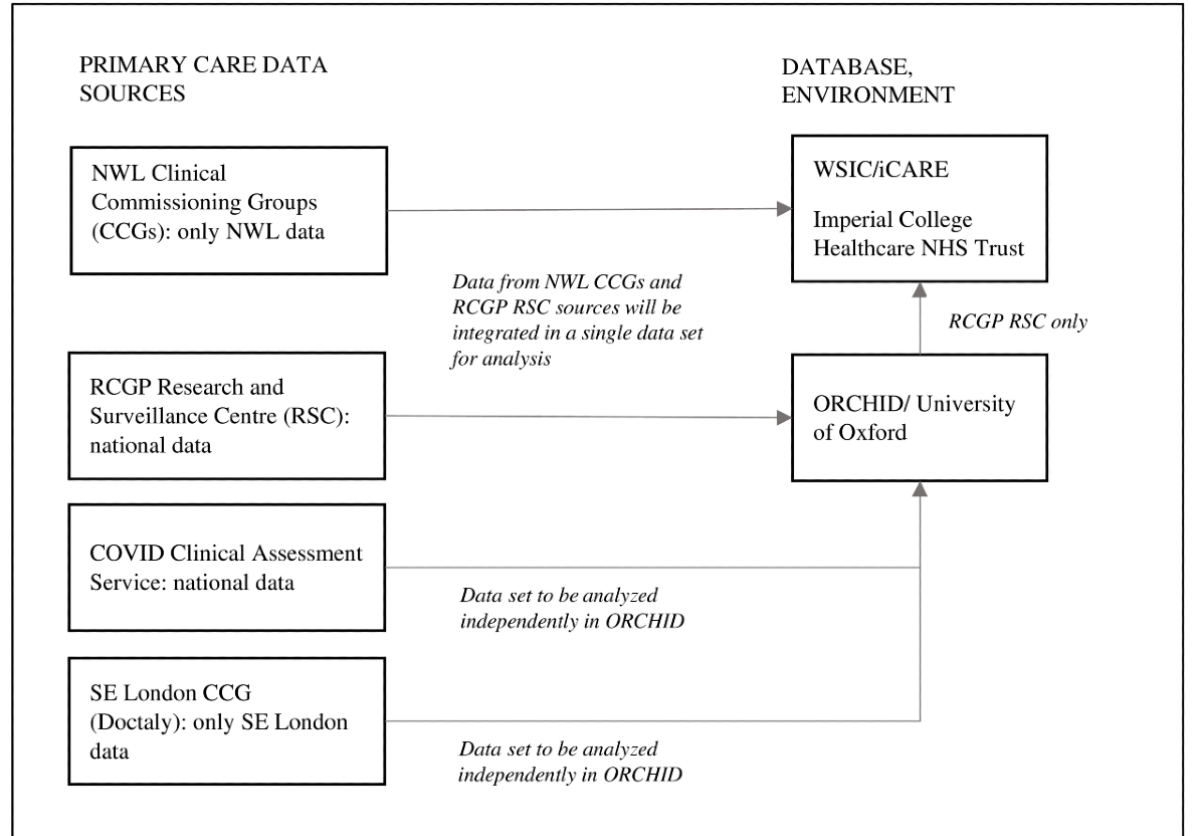
Figure 2. Data flowchart. CCG: Clinical Commissioning Group; NHS: National Health Service; NWL: North West London; ORCHID: Oxford RCGP Clinical Informatics Digital Hub; RCGP: Royal College of General Practitioners; RSC: Research and Surveillance Centre; SE: South